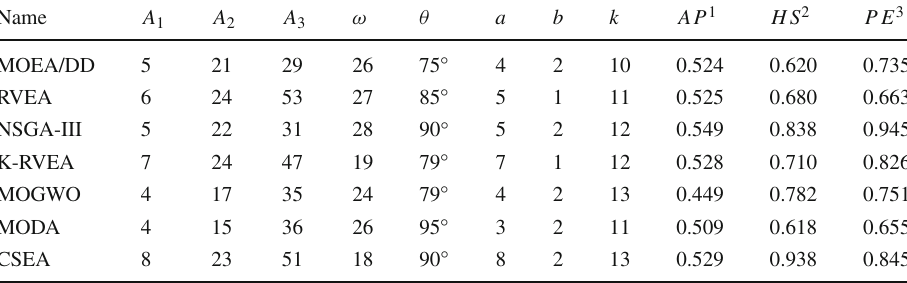
Fig.12 a Simulated and experimental velocity of the propulsion speed in x direction. b Simulated and experimental angular velocity of the proposed biomimetic robotic fish. c Simulated and experimental veloc-